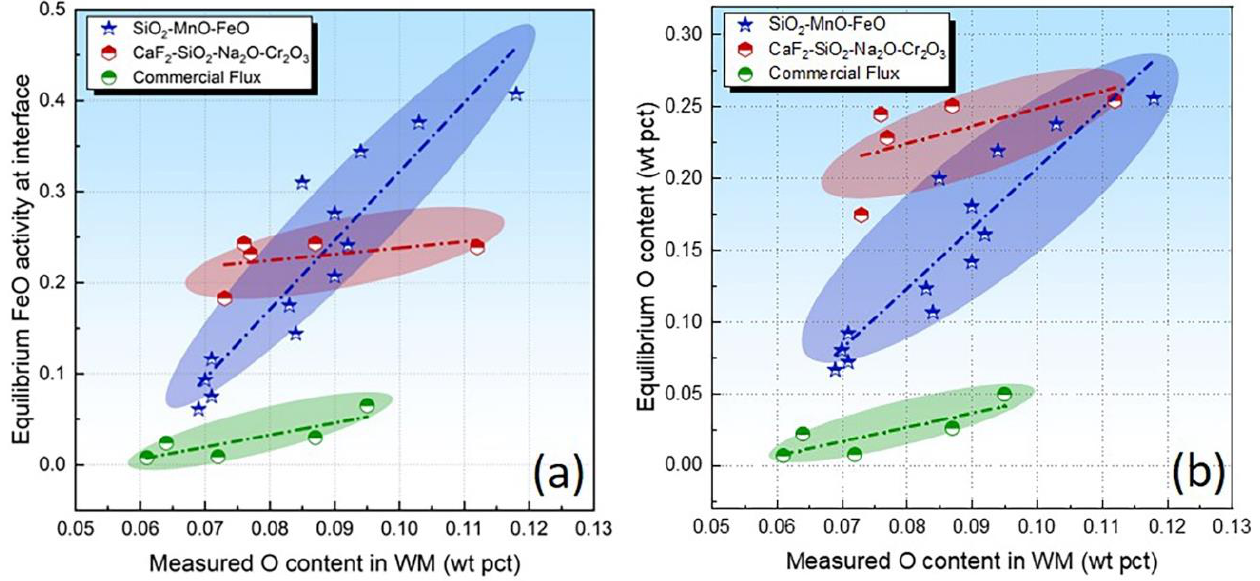
Figure 6. Equilibrium FeO activity ( a ) and O content ( b ) as a function of measured O content in WM.